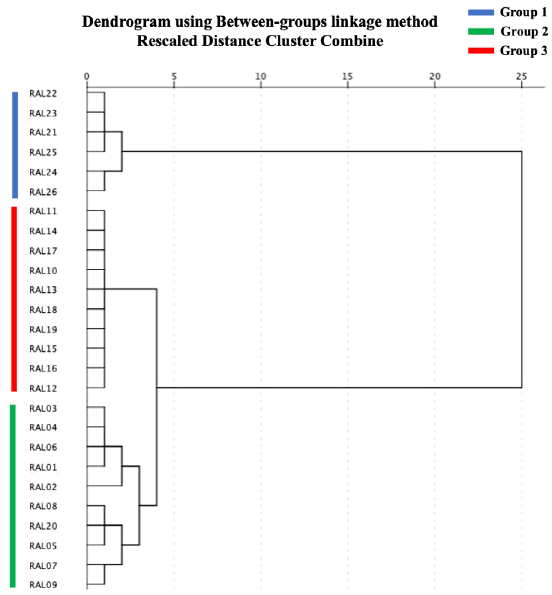
Figure 3. HCA dendrogram of 26 RAL samples from different regions using the between-groups linkage method based on squared Euclidean distance.